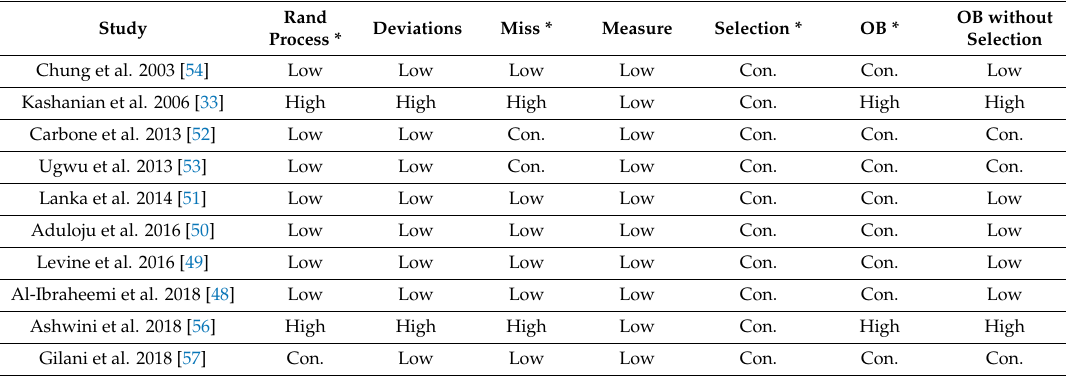
Table 1. Study Risk of bias